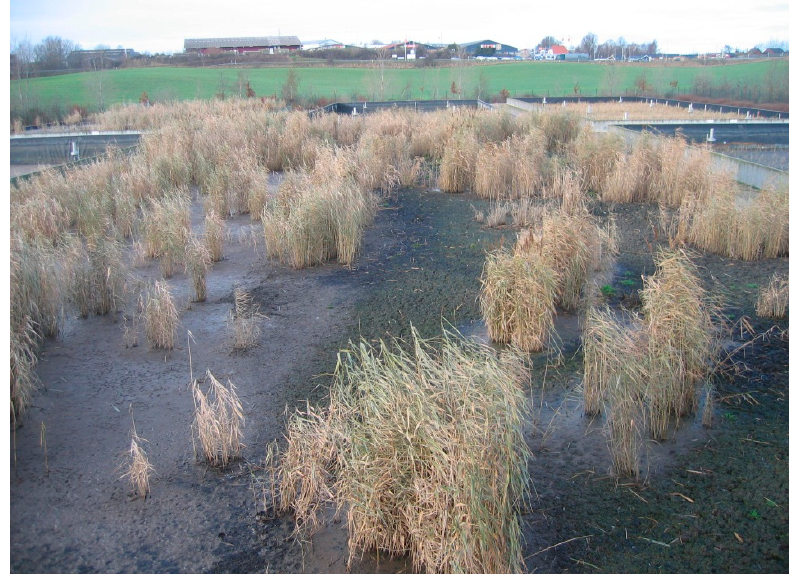
Figure 5. Typical sludge treatment reed beds with operational problems as indicated by the reduced and clumped growth of the reeds (photo: H. Brix).